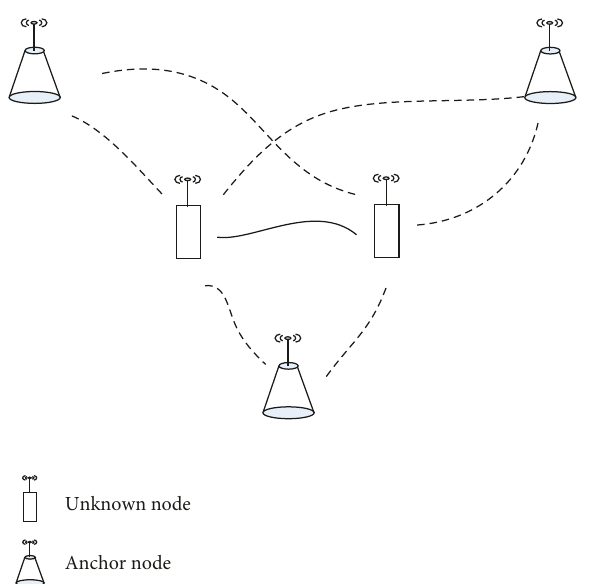
Figure 1: The positioning panorama for IoT